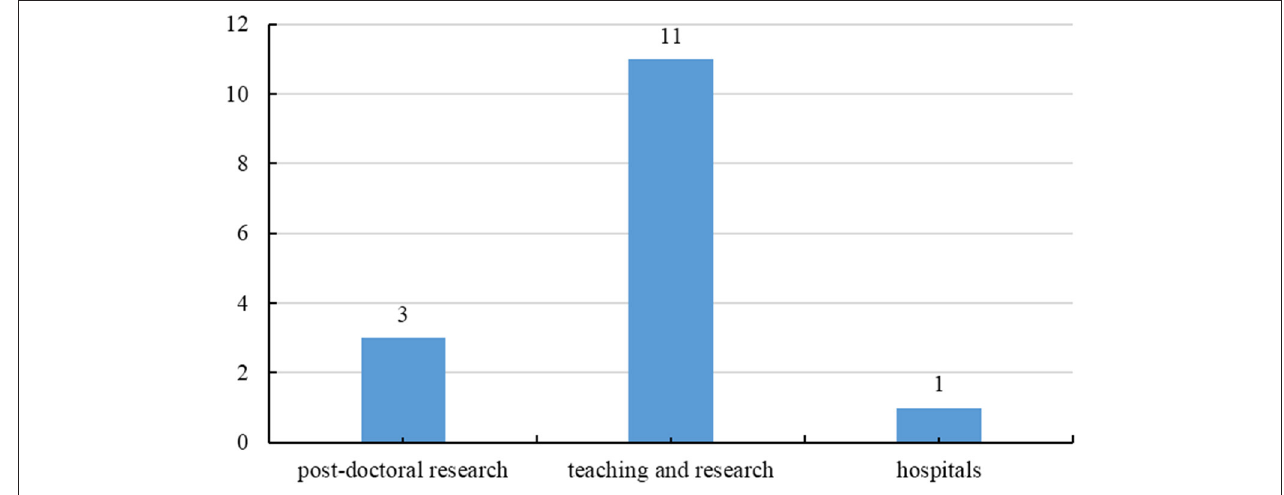
FIGURE 2 | Graduate career paths of